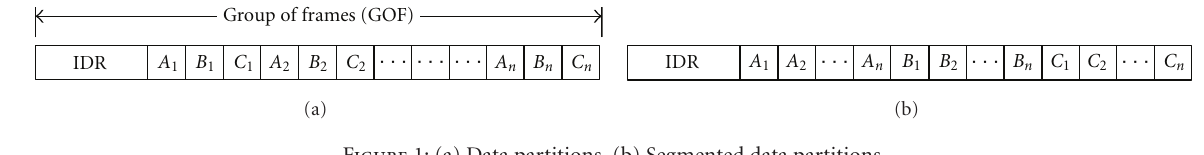
Figure 1: (a) Data partitions. (b) Segmented data